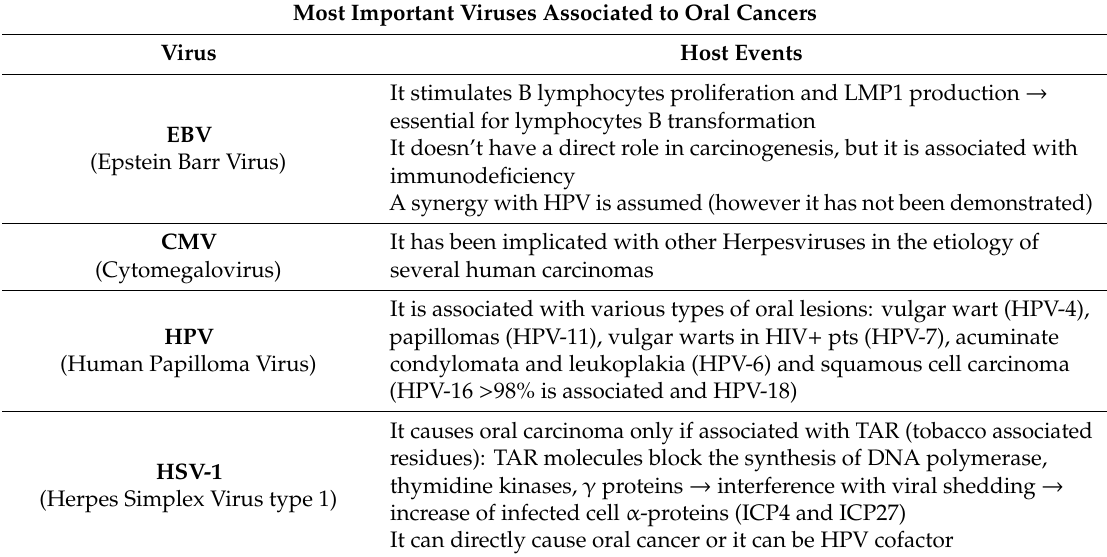
Table 3. The most important viruses associated with oral cancers and their molecular e ff ects in the